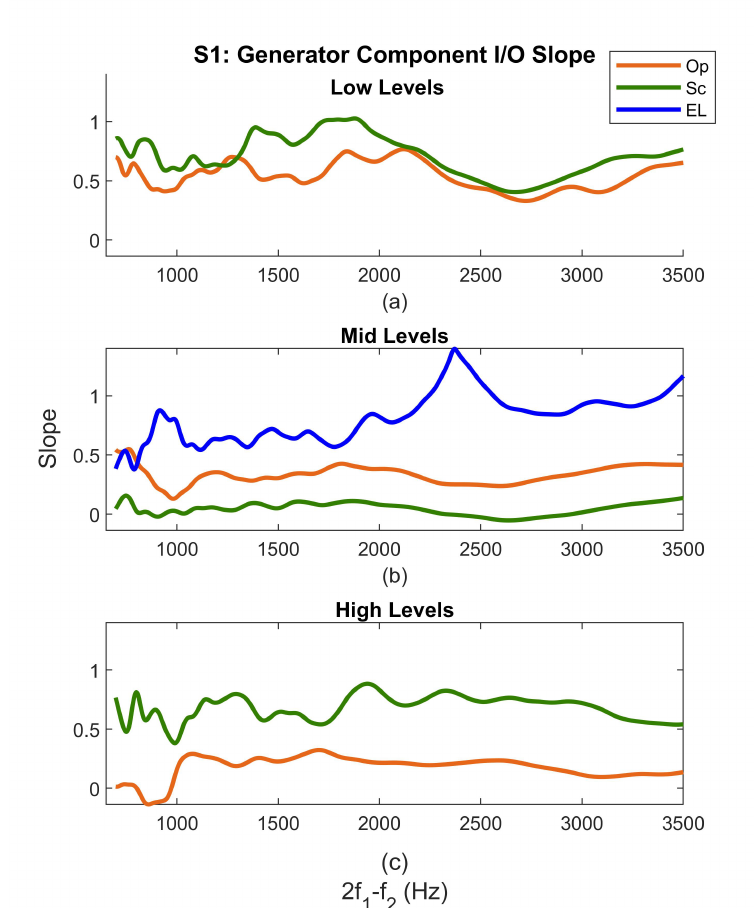
Figure 6. I / O gen slope at low, mid, and high L 2 s in the Op (orange), Sc (green), and EL (blue) paradigms across frequency for subject